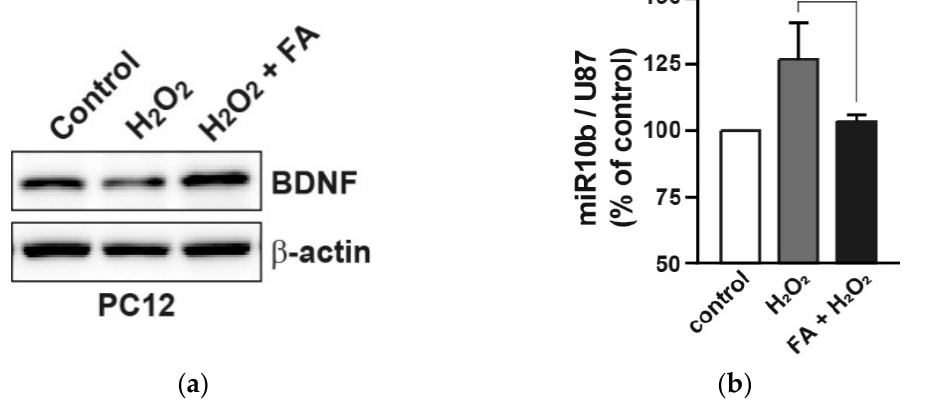
Figure 4. FA increases the reduced BDNF expression by H 2 O 2 in PC12 cells. ( a ) PC12 cells were pretreated with FA (40 µM) overnight and subsequently cultured cells in the absence or presence of H 2 O 2 (25 µM) for 24 h. Cell lysates were analyzed by Western blot analysis. ( b ) Expression levels of miR-10b were measured by qRT-PCR. miR-10b levels were normalized to U87 microRNA. Data represent the mean ± SD.